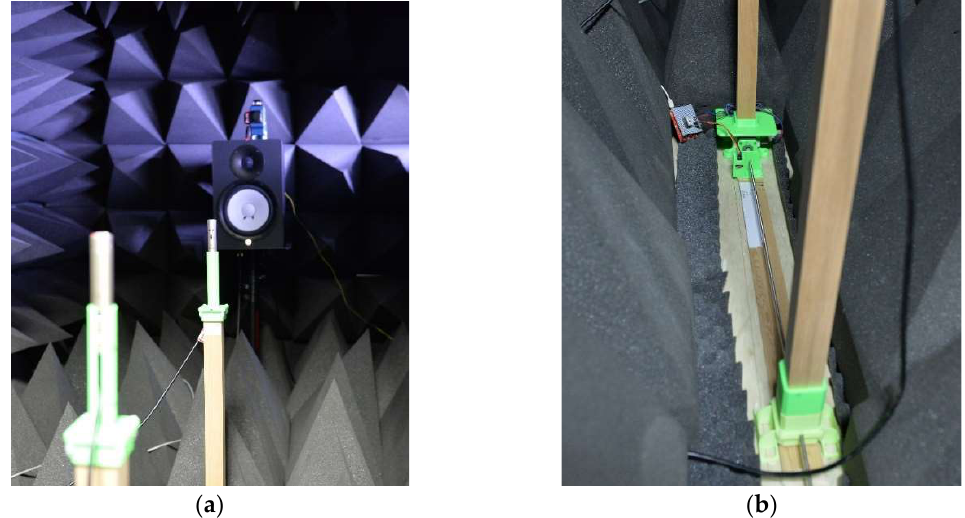
Figure 17. Acoustic experiment in the anechoic chamber: ( a ) two microphones & speaker configuration with laser guidance; ( b ) automatic relocation system to control microphone distance.